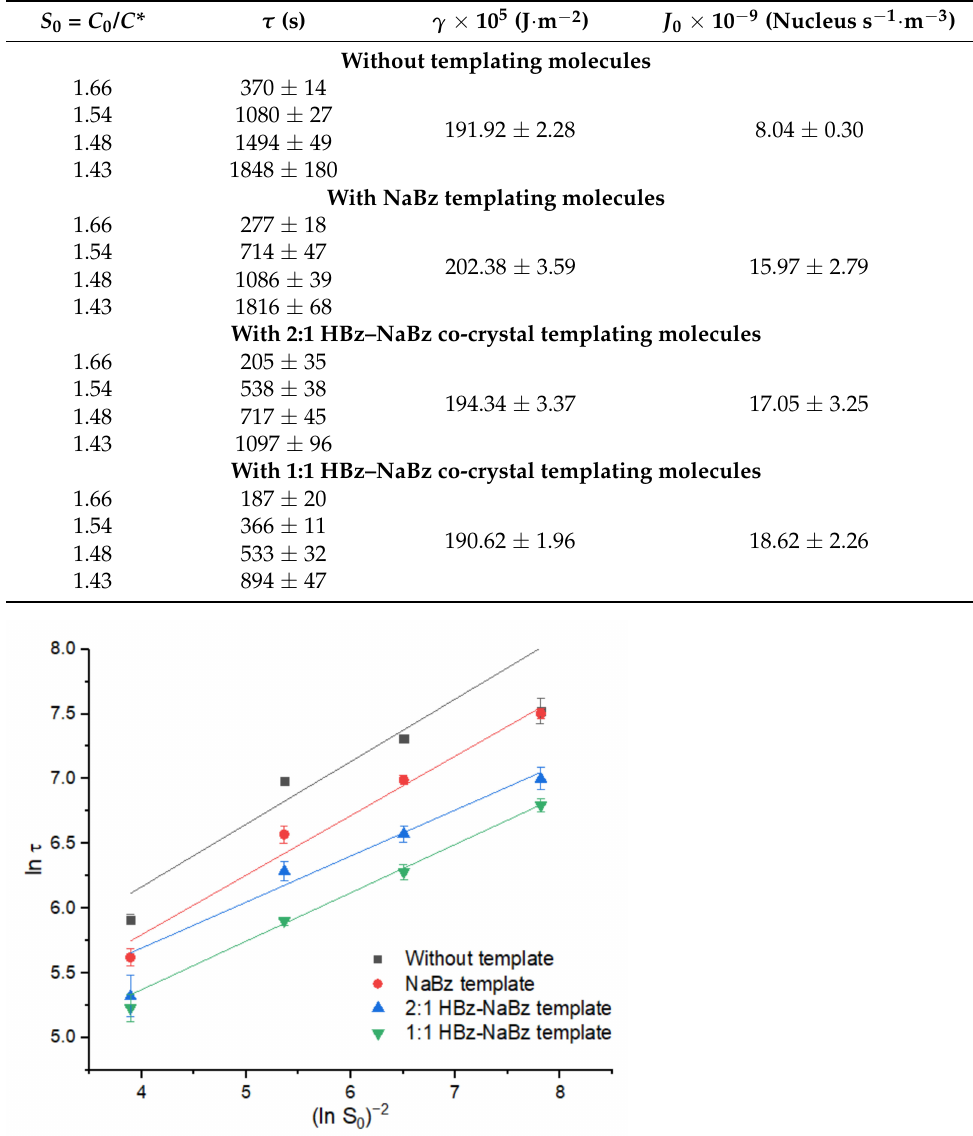
Figure 5. Plots of (ln S 0 ) − 2 vs. ln τ of co-crystallization of 2:1 HBz–NaBz co-crystal with and without templating molecules fitted to Equation (12) based on the data in Table